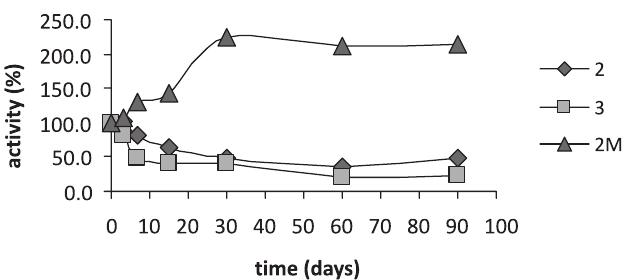
FIGURE 2 – Papain activity variation (%) for formulations 2, 3, 2M and Gel at 22 ± 2.0 ° C during the Normal Stability Test.